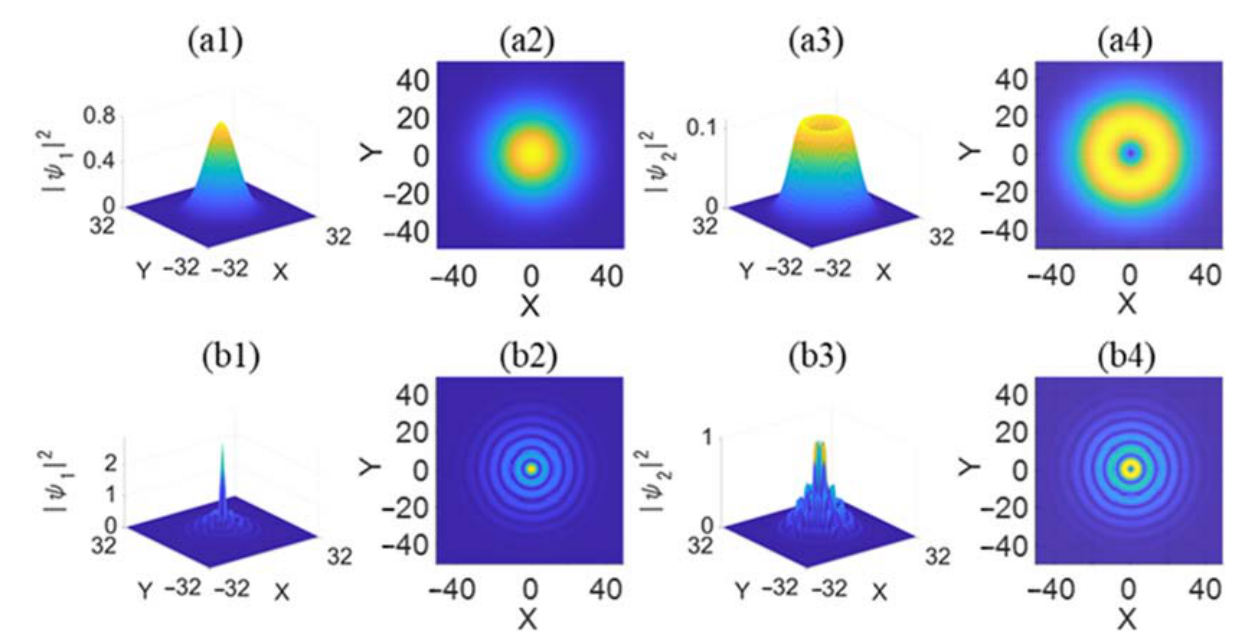
Figure 5. The density profile and spatial distributions of the soliton pairs for stable zero ‐ vorticity